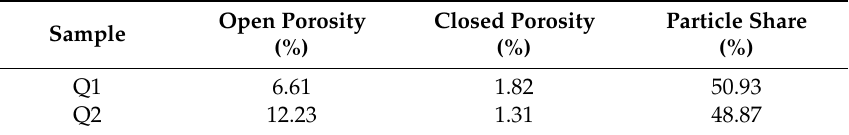
Table 7. Porosity and percentage of particles in Samples Q1 and Q2 after heating at 950 °C. Open Sample